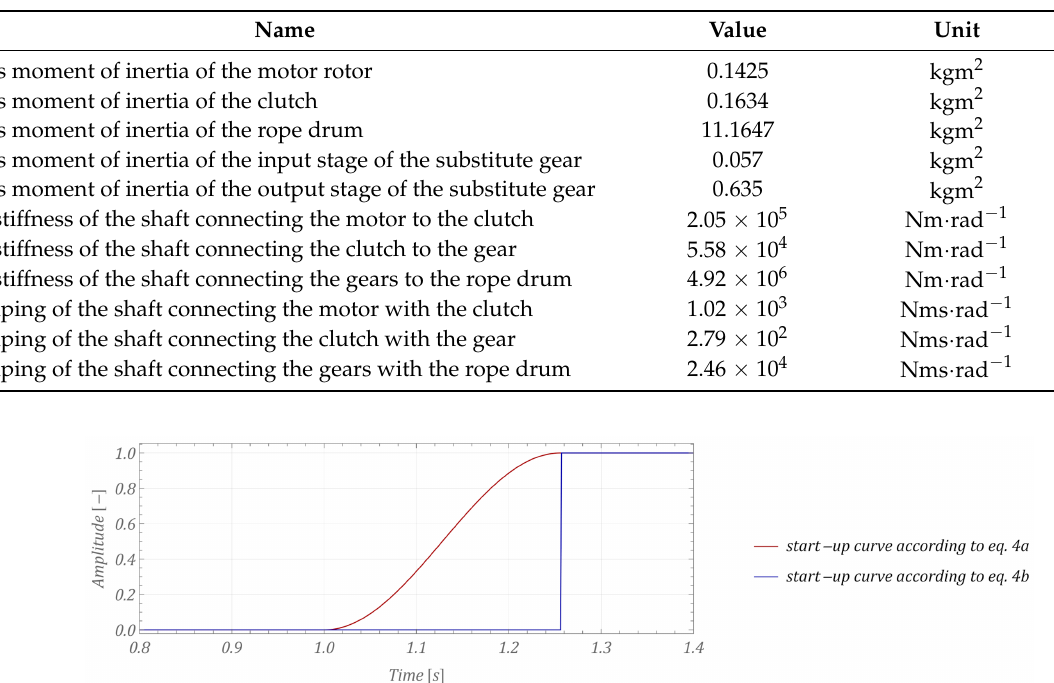
Figure 3. Rope stiffness for E l = 0.5 E s (metallic rope cross section). Table 3. Physical parameters describing the model of the drive system.